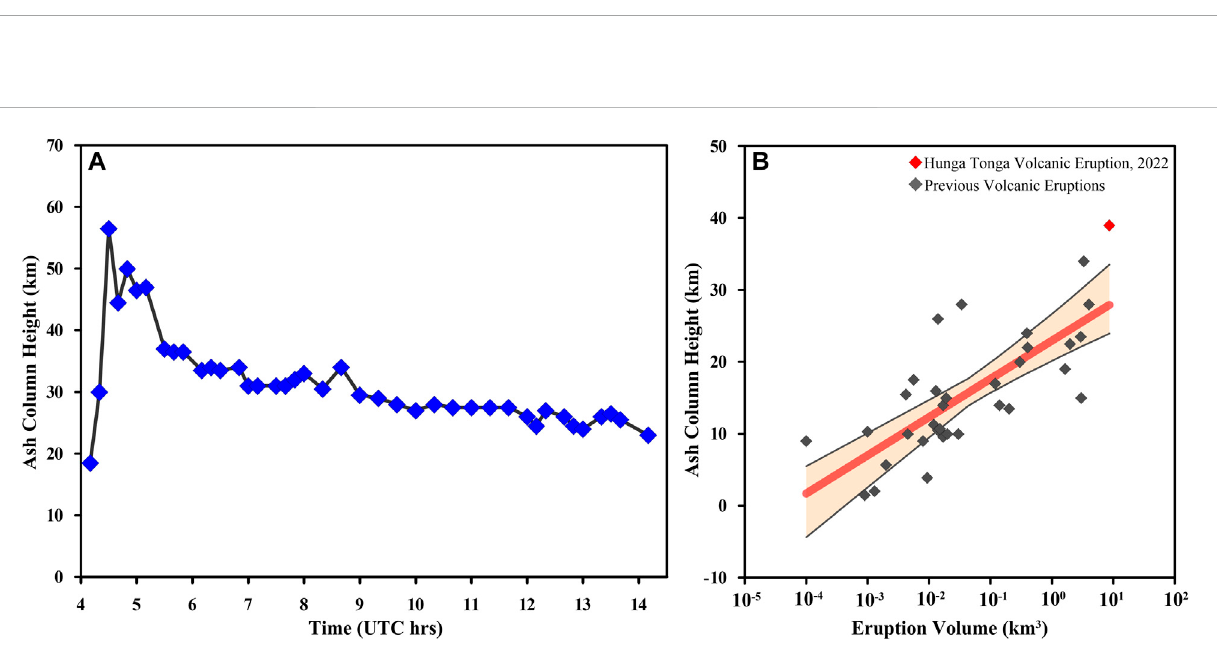
FIGURE 4 (A) Time series of the ash column height of the main phase of the Hunga Tonga eruption on 15 January 2022 (see Supplementary Table S5). (B) Ash column height (in km) versus VEI plot of some known volcanic eruptions. Previous eruptions are denoted by gray symbols (see Supplementary Table S5); the Hunga Tonga eruption is denoted by red symbols. Red line represents the linear regression line of the data. Black lines above and below the red line indicate the 95% con fi dence